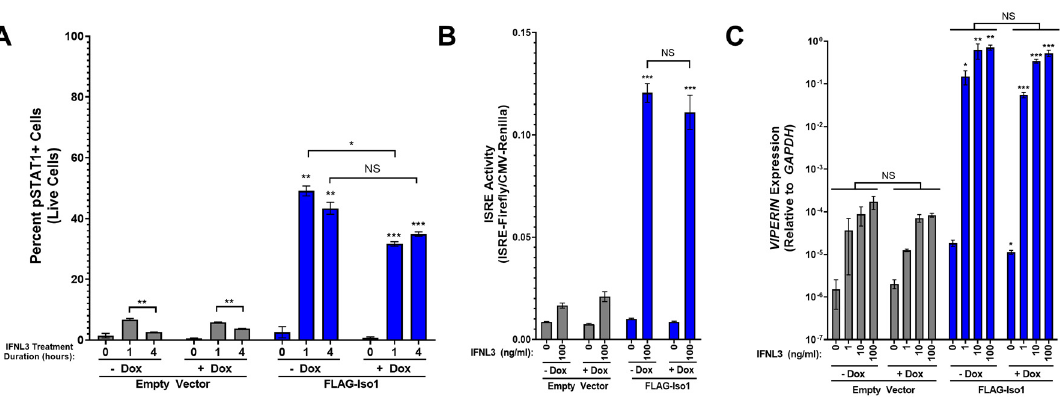
Figure 3. FLAG-Iso1 overexpression augments the cellular response to IFNL3. ( A ) Quantitation of percent pSTAT1+ in HEK293T-EV and FLAG-Iso1 cells after 0, 1, and 4 h of IFNL3 treatment (100 ng/mL) (representative data, two independent experiments). ( B ) HEK293T-EV and FLAG-Iso1 cells were co-transfected with plasmids encoding Firefly Luciferase under control of an ISRE promoter and Renilla Luciferase under control of a CMV promoter. Cells were treated ±dox (100 ng/mL) for 24 h prior to mock or IFNL3 (100 ng/mL) treatment for 24 h and harvested for dual luciferase assay (representative data, three independent experiments). ( C ) HEK293T-EV and FLAG-Iso1 cells were treated ±dox (100 ng/mL) for 24 h prior to IFNL3 treatment for 24 h (0, 1, 10, or 100 ng/mL), then harvested for qRT-PCR analysis of VIPERIN and GAPDH (representative data, four independent experiments). Statistical significance represented by lone asterisks reflect comparisons between identically treated EV and FLAG-Iso1 cells. Statistical significance represented by bars and asterisks reflect comparisons between -dox and +dox conditions within each cell line. Error bars represent standard error of the mean. * = p < 0.05, ** = p < 0.01, *** = p < 0.001. NS = not significant.